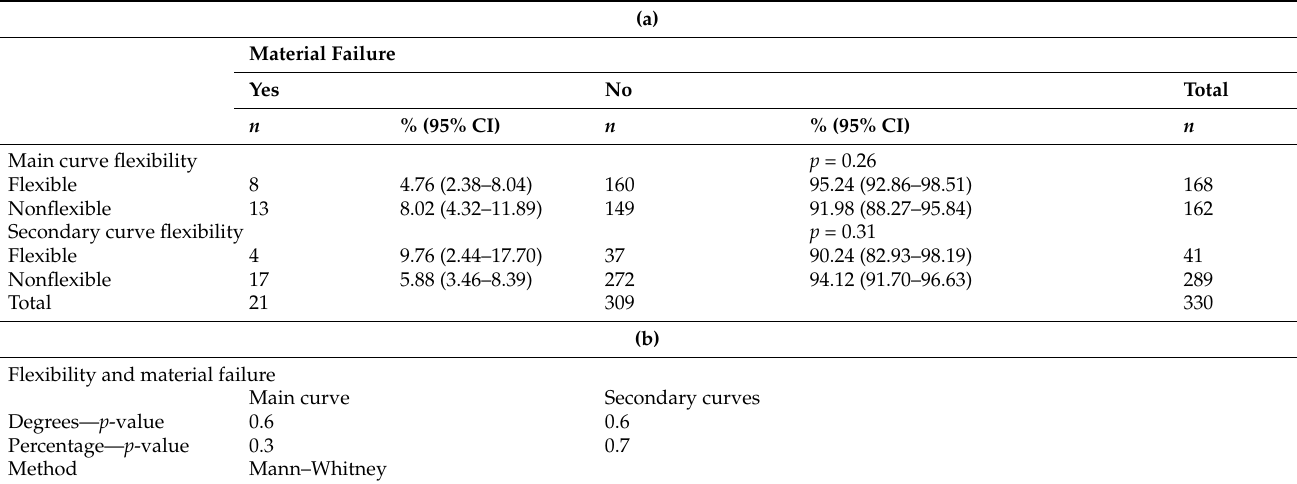
Table 3. Analysis of curve flexibility and associations with the occurrence of material failure. ( a ) Chi- square test of main and secondary curve flexibility compared with occurrence of material